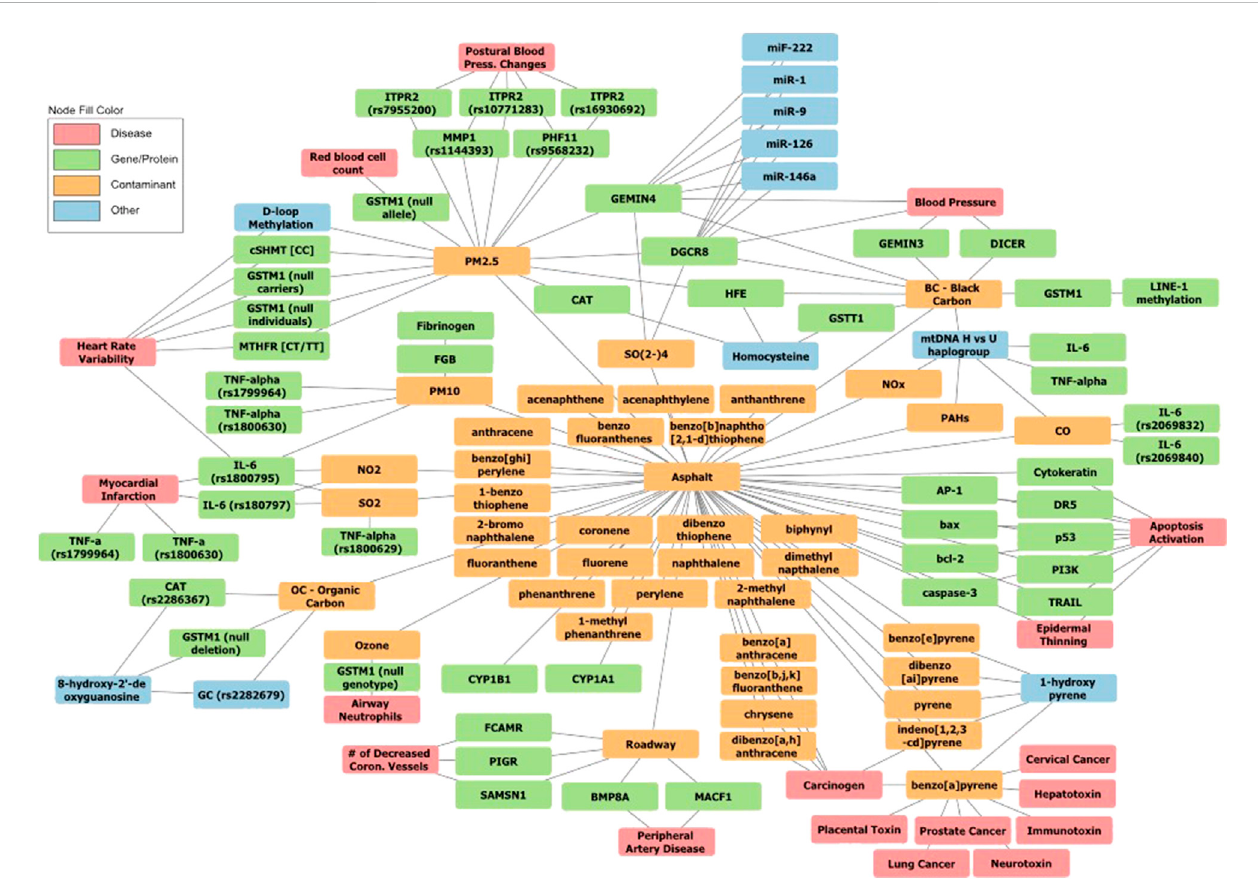
Network graph of pollutants, biomolecular targets and health effects. Nodes are color labeled by type. Orange nodes indicate pollutants identi fi ed as being emitted by asphalt. Green nodes are proteins or genes that encode proteins that are affected by exposure to asphalt constituents. Dark blue nodes are diseases or health effects associated asphalt exposure. Light blue nodes are small molecule biomarkers, posttranslational modi fi cations impacted by speci fi c emissions from asphalt, and mitochondrial DNA that do not fall neatly into another group (Khare et al., 2020; Breuer et al., 2011; Burstyn et al.,